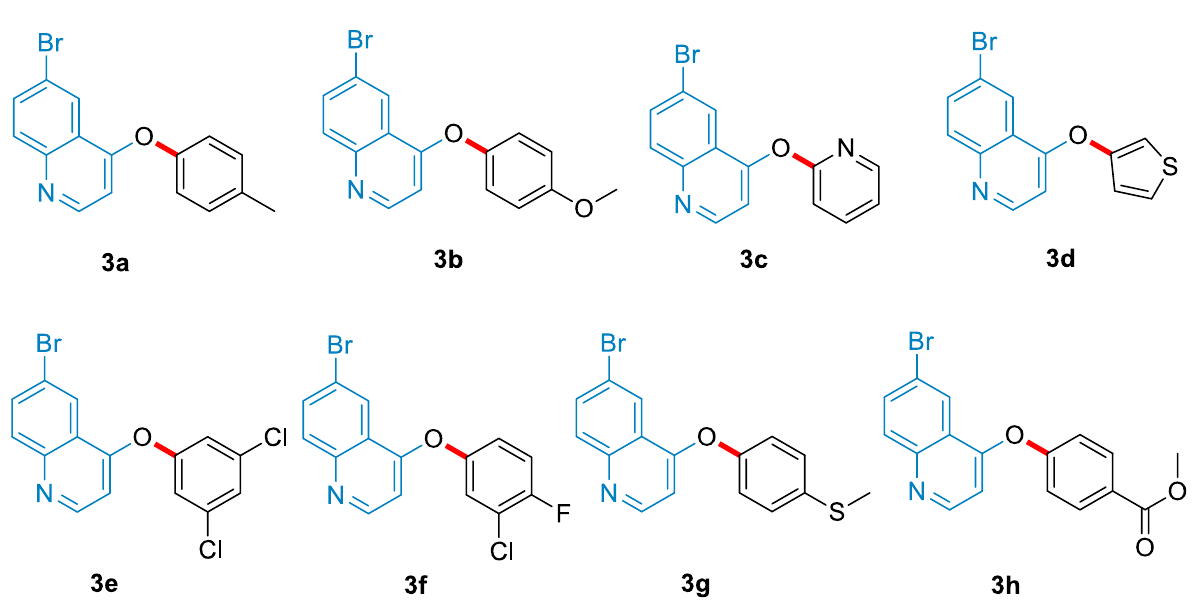
Figure 1. An overview of 6-bromoquinolin-4-ol derivatives ( 3a – 3h ).